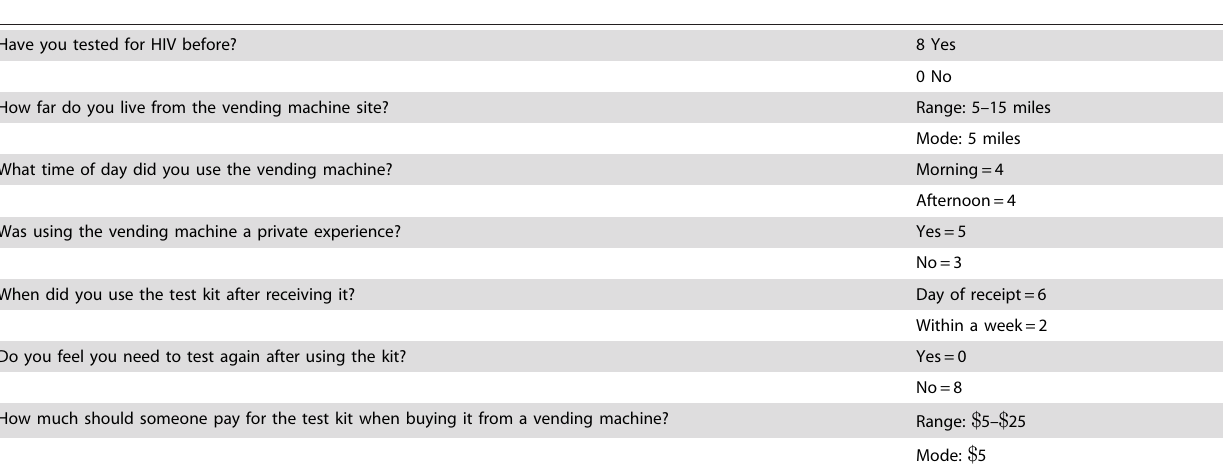
Table 1. Vending Machine and HIV Test Kit Usage Behavior.